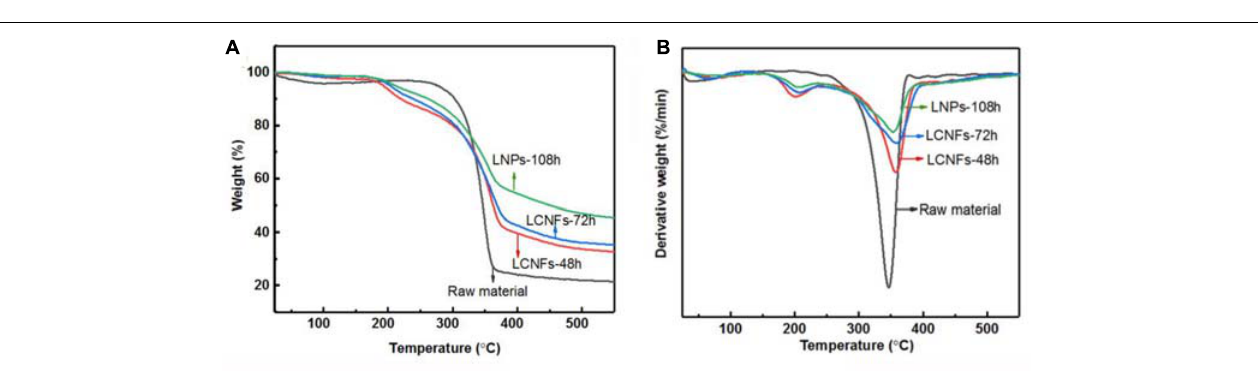
exhibit very stable colloidal suspensions in aqueous media for over 1 month, indicating excellent